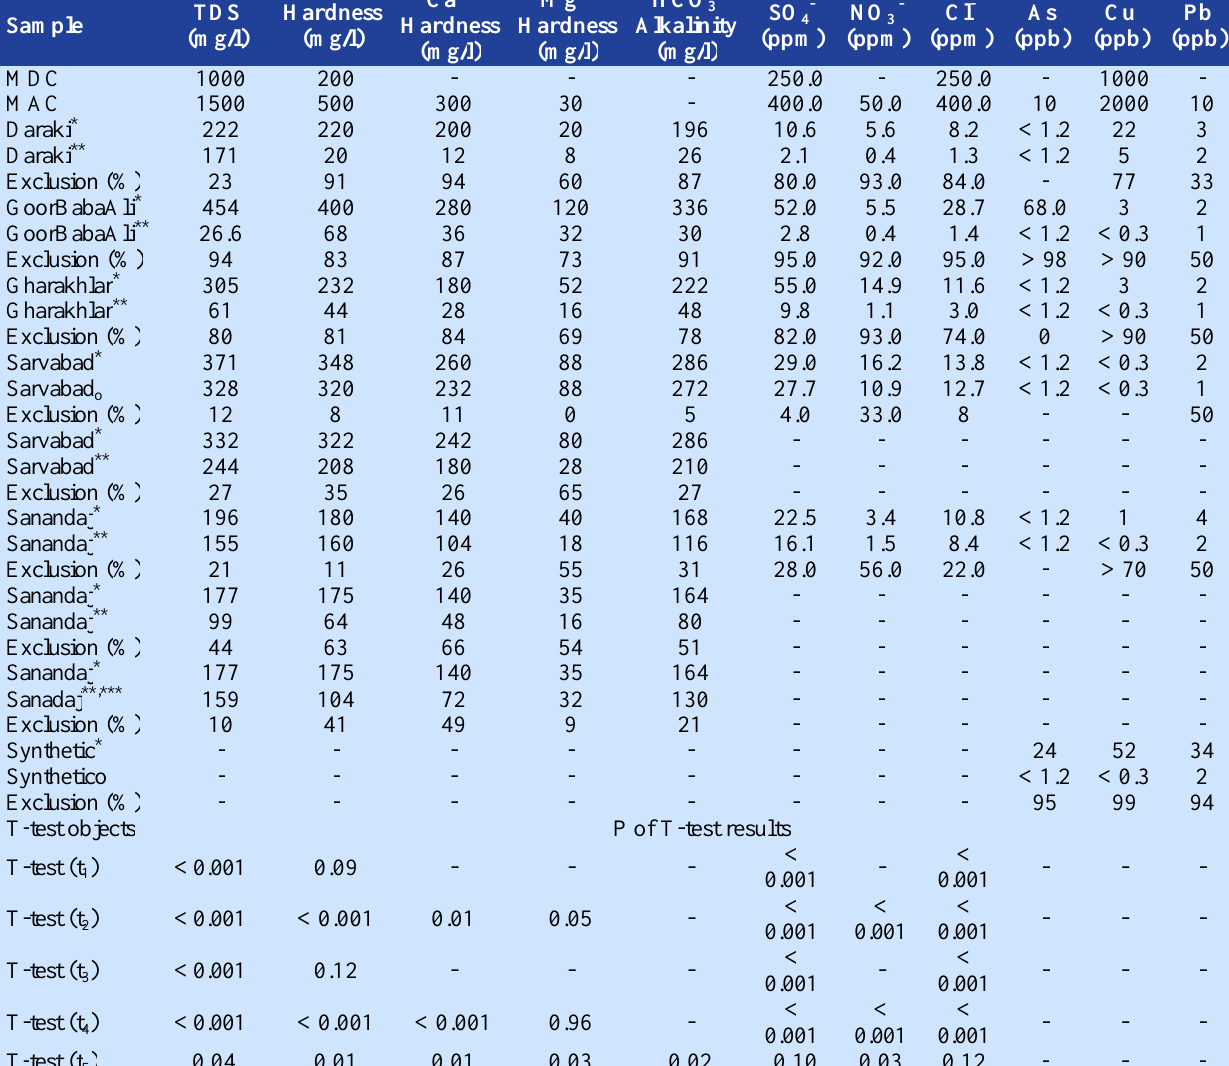
Table 1. Experimental and standard values of investigated physico-chemical parameters